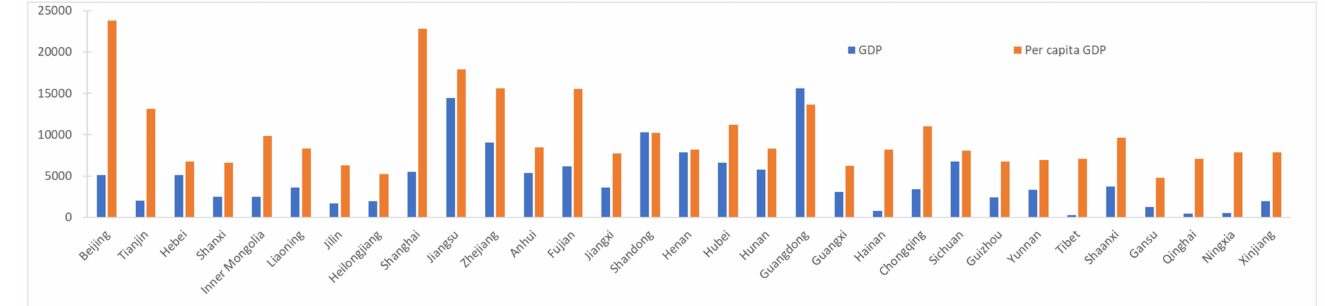
Figure 2. Comparative analysis of economic development in China’s provinces.